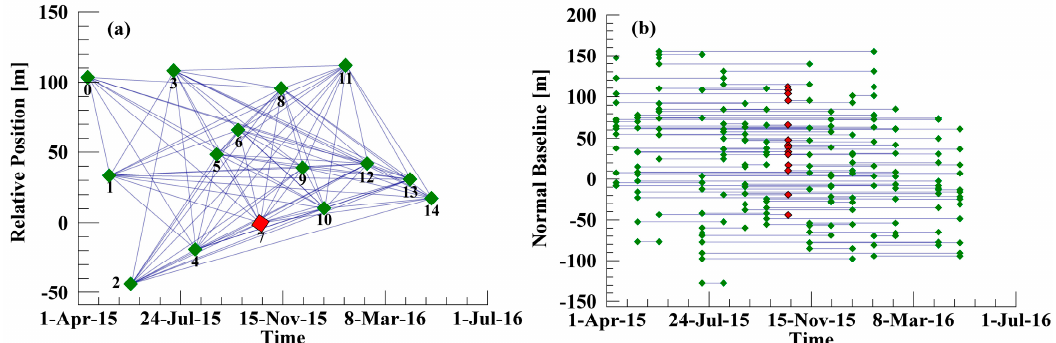
Figure 2. ( a ) Time–position of Sentinel-1A image interferometric pairs; and ( b ) time–baseline of Sentinel-1A image interferometric pairs. The red diamond denotes the super master image. Blue lines represent interferometric pairs. Green diamonds denote slave images.